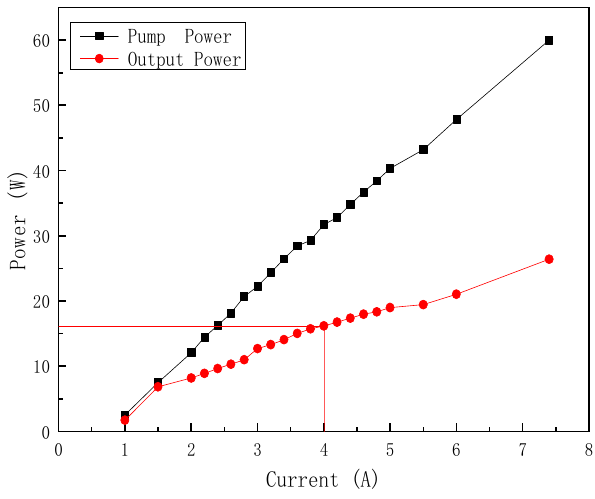
Figure 2. Output power of 808 nm LD and the 1064 nm output laser versus pump current.